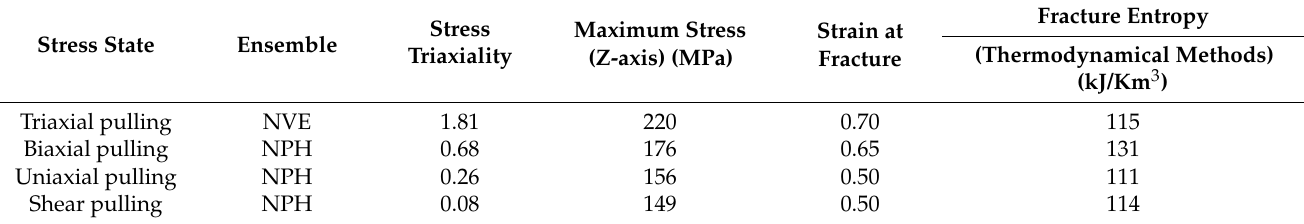
Table 2. Simulation results: relationship between stress triaxiality, maximum stresses, strain at fracture, and fracture entropy.